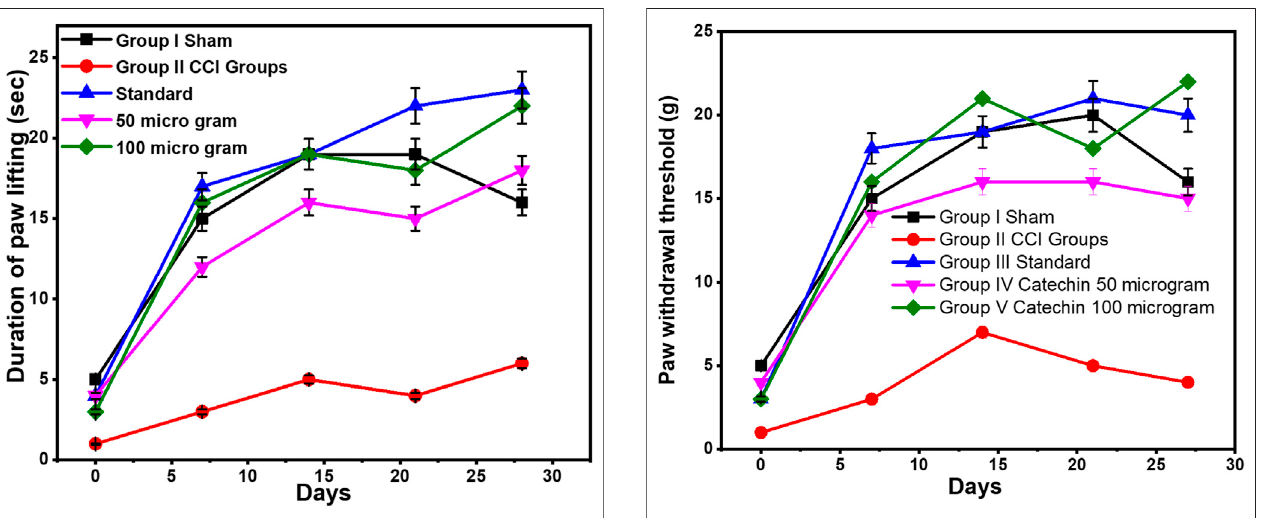
FIGURE2| Assessmentofcoldallodyniausingthecoldplatetechnique. Values are expressed as mean ± SEM for six animals in each group. Signi fi cance was determined by a two-way analysis of variance. p < 0.001 when compared with sham and CCI.